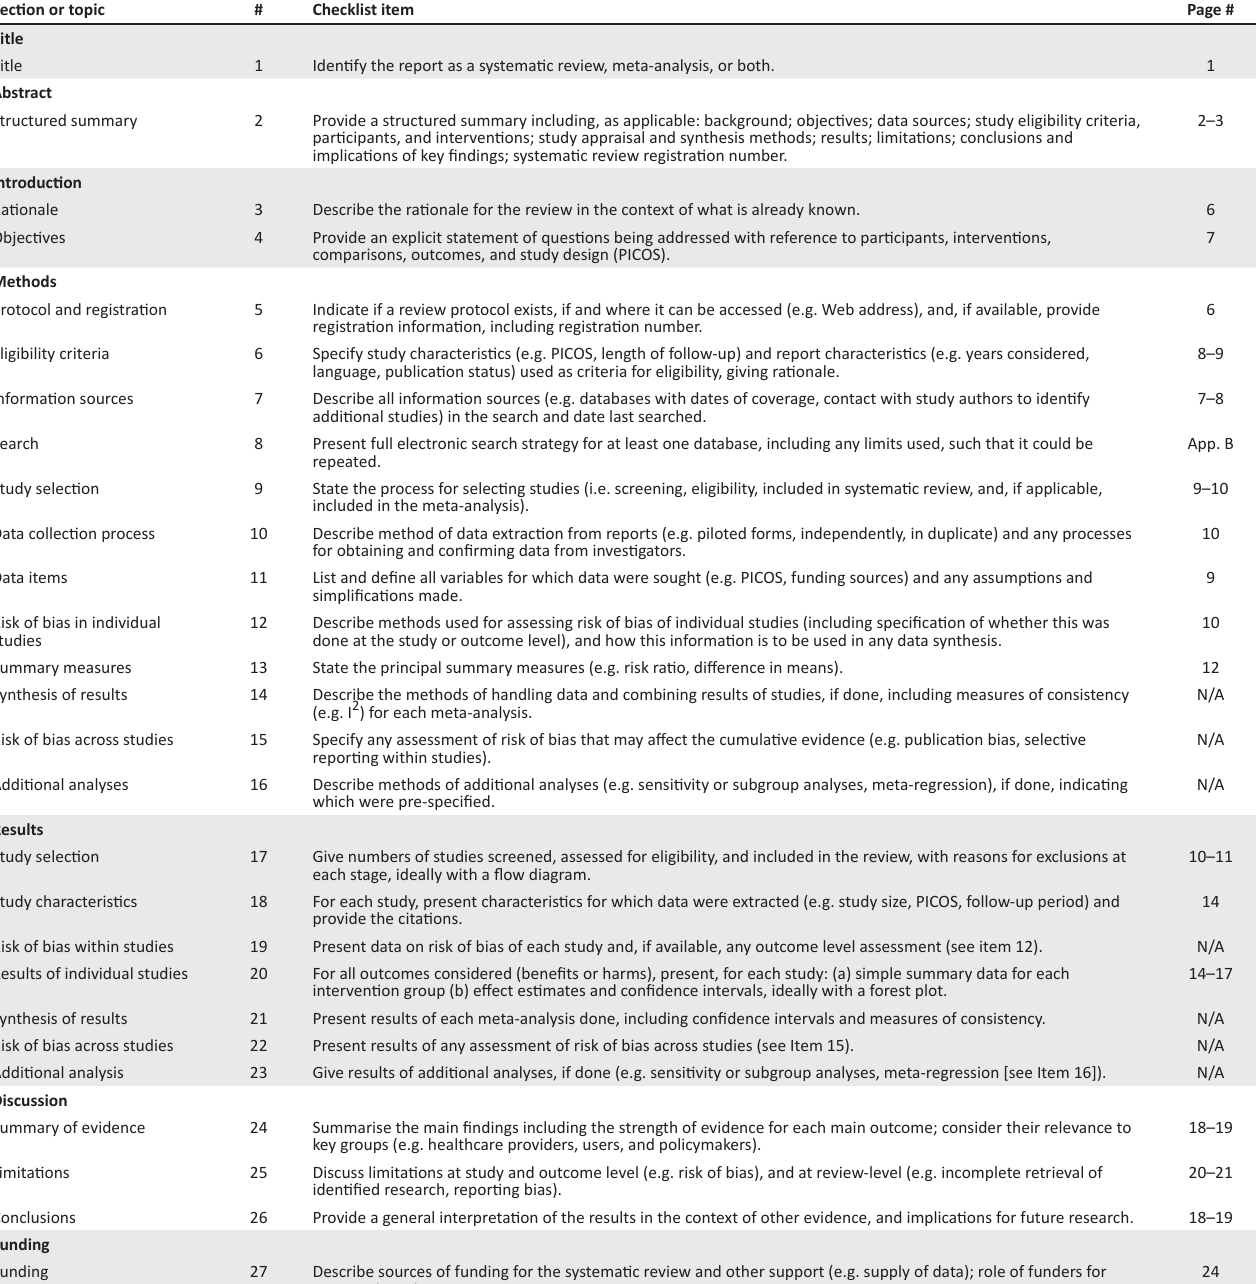
TABLE 1-A1: Preferred Reporting Items for Systematic Reviews and Meta-Analyses checklist for systematic reviews and